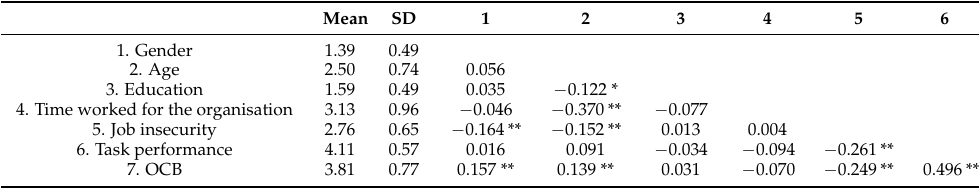
Table 3. Mean, standard deviation and Spearman correlations.